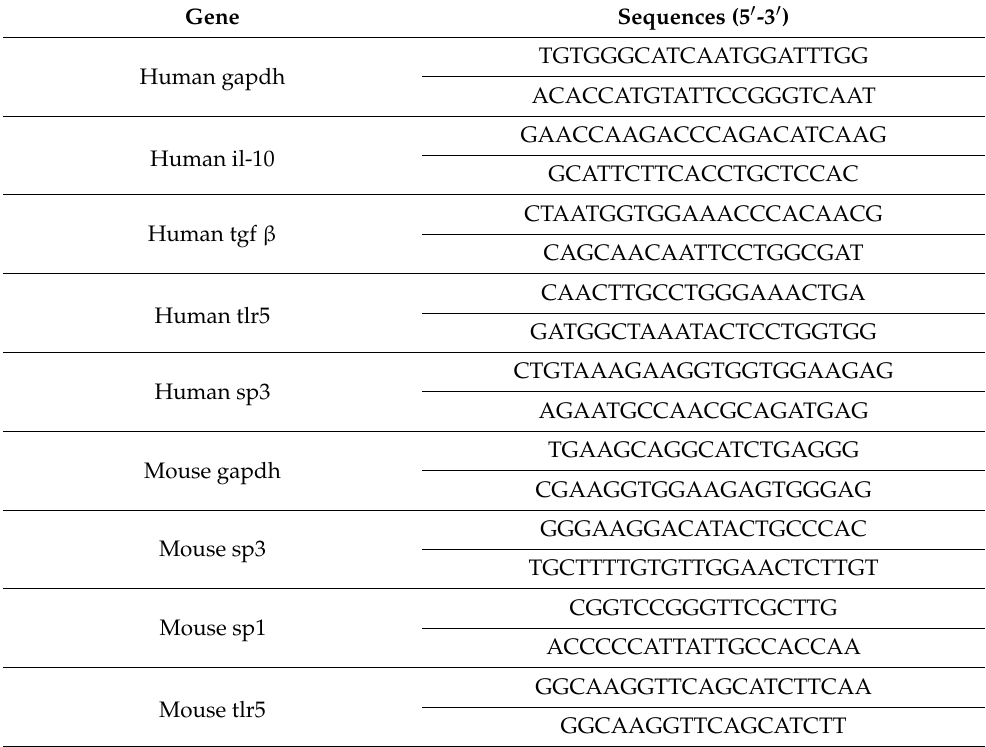
Table 1. Primer sequences used for